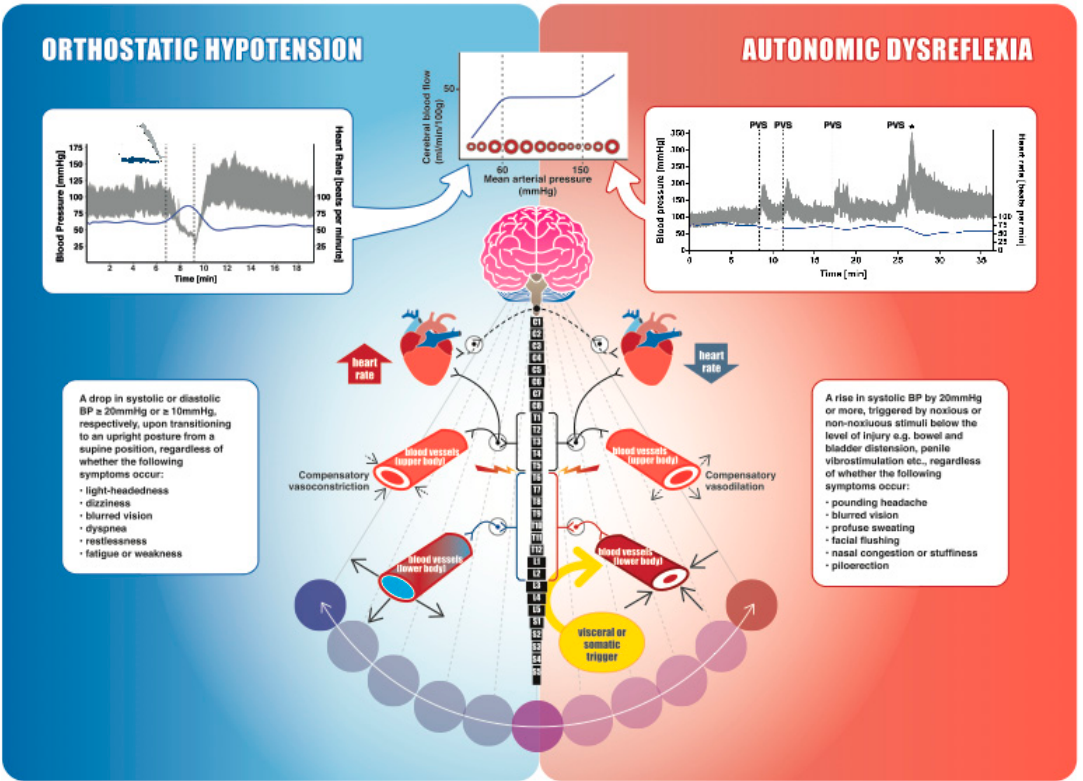
Figure 1. An overview of spinal cord injury (SCI), autonomic cardiovascular innervation, blood pressure (BP) instability, and cerebral autoregulation. The schematic diagram in the middle demonstrates autonomic control of the cardiovascular system. Parasympathetic control of the heart (dashed line), mediated by the vagus nerve, usually remains intact following SCI. Neurons within the brainstem provide sympathetic tonic control to spinal sympathetic preganglionic neurons. Heart and upper-body blood vessels are innervated via spinal segments T1–T5, whereas the trunk and lower extremity vasculature receive innervation from T6–L2. The splanchnic bed (liver, spleen, and intestines) is densely innervated, highly compliant, and contains approximately one-quarter of the total blood volume at rest, making it the primary capacitance bed. An SCI disrupting the sympathetic control of these vessels (i.e., at or above T6) makes them highly vulnerable to vasodilation and extreme constriction, leading to BP instability. Orthostatic hypotension (shown on the left): cardiovascular changes in a participant with a motor-complete cervical SCI (C5, American Spinal Injury Association Impairment Scale (AIS) A) during a head-up-tilt assessment. Beat-by-beat BP is shown in grey, and heart rate is shown in blue. BP plummeted immediately upon initiation of 60 ◦ upright tilt from the supine position and the tilt was terminated after 2 min. Mean arterial pressure was recorded as 25 mmHg at its lowest, well below the lower limit of cerebral autoregulation (top middle inset). Rebound hypertension was also apparent when the participant was returned to the supine position, further emphasizing the instability in blood pressure regulation. Autonomic dysreflexia (shown on the right): cardiovascular changes in a male with motor-incomplete SCI (C6, AIS C) during a sperm retrieval procedure with penile vibrostimulation (PVS), which is a visceral / somatic trigger originating below the spinal lesion. The dashed lines indicate each time the PVS is applied and is followed by significant and rapid increases in BP. * indicates ejaculation. In this case, systolic BP almost triples and mean arterial pressure is ~250 mmHg, well above the upper limit of cerebral autoregulation (top Figure). Cerebral autoregulation curve (shown on the top): cerebral blood flow (CBF) is shown in relation to cerebral artery lumen diameter and mean arterial pressure. The dashed lines represent the lower and upper limits of CBF autoregulation, which are exceeded by our clinical orthostatic and autonomic dysreflexia examples. Red circles represent the cerebral arteries (either vasodilating or vasoconstricting to counteract changes in systemic blood pressure), and the blue solid line represents cerebral blood